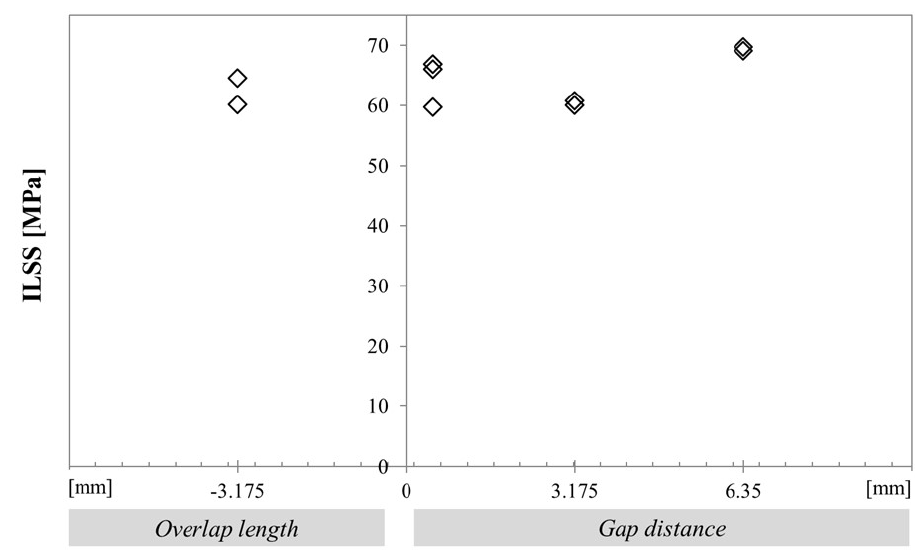
Figure 5. Apparent Interlaminar shear stress variation as a function of the type of embedded defect with caul plate, [90/0 7 /90 2 /0 7 /90].